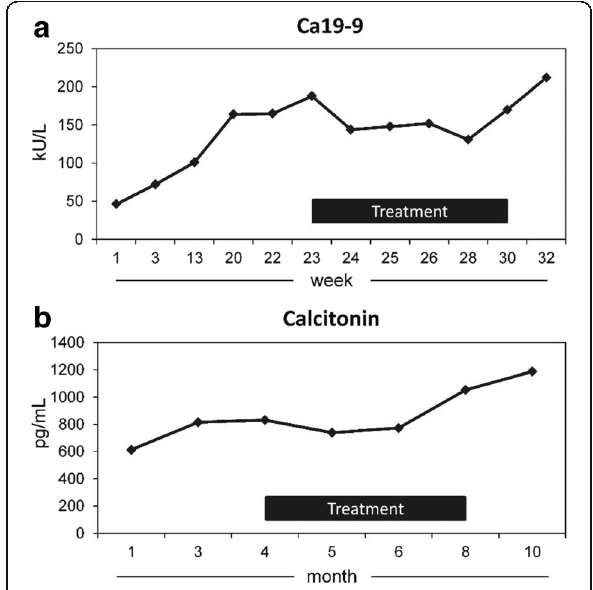
Fig. 2 Tumor markers of a patient with pancreatic cancer ( a ) and a patient with metastasized C-cell carcinoma ( b ) before, during and after treatment with 700 mg ( a ) and 2000 mg ( b ) Helixor® P. After 3 weeks in the study, treatment was continued off label until tumor markers increased